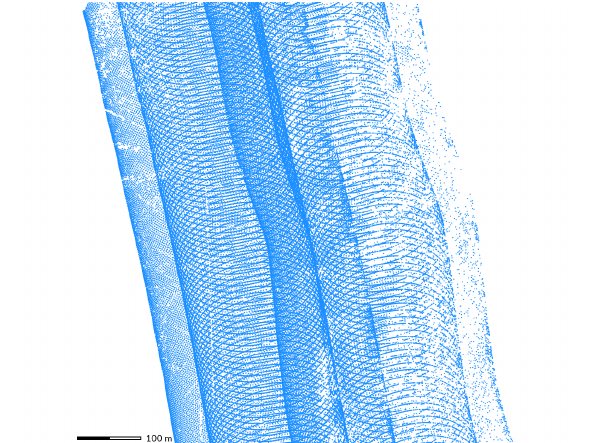
Figure 3. Point cloud from several overlapping swaths with an elliptical scan pattern (two swaths in the middle of the stripe of points). Elliptical scanning causes a higher point density at the edge of each swath. Dataset: NOAA/NASA/USGS 1999 [45]. Table 2. Point density variations related to scanner and